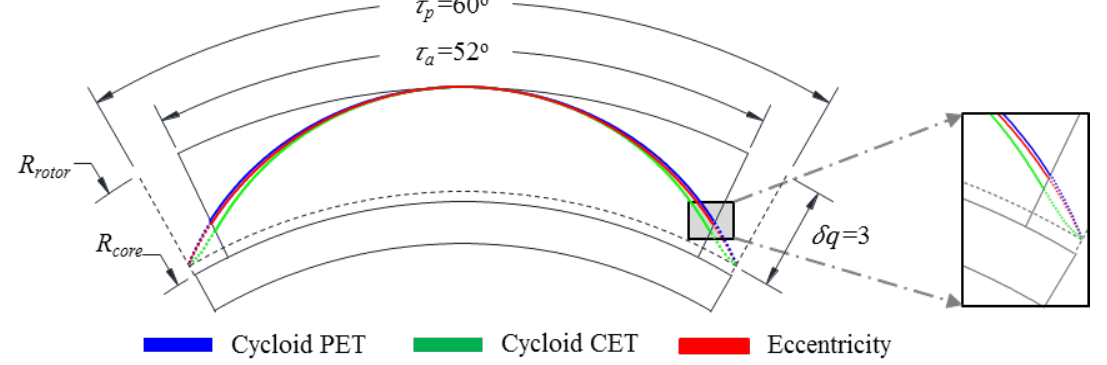
Figure 6. Magnet shape at δq = 3: CET, PET, and eccentricity.